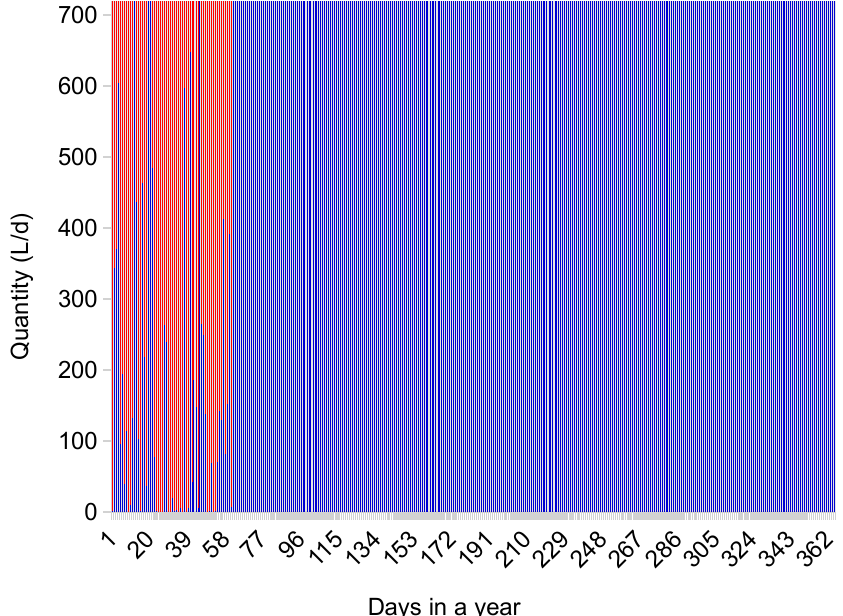
Figure 4. Daily requirements supplied through RWH (blue bars) and the corresponding required supplementary supply (red bars) to meet a demand of 360 L d − 1 for a given family for a catchment area of 100 m 2 . Note that for any given day, the demand that is not met through RWH, is met through supplementary sources to meet the total demand (i.e., 360 L d − 1 ).